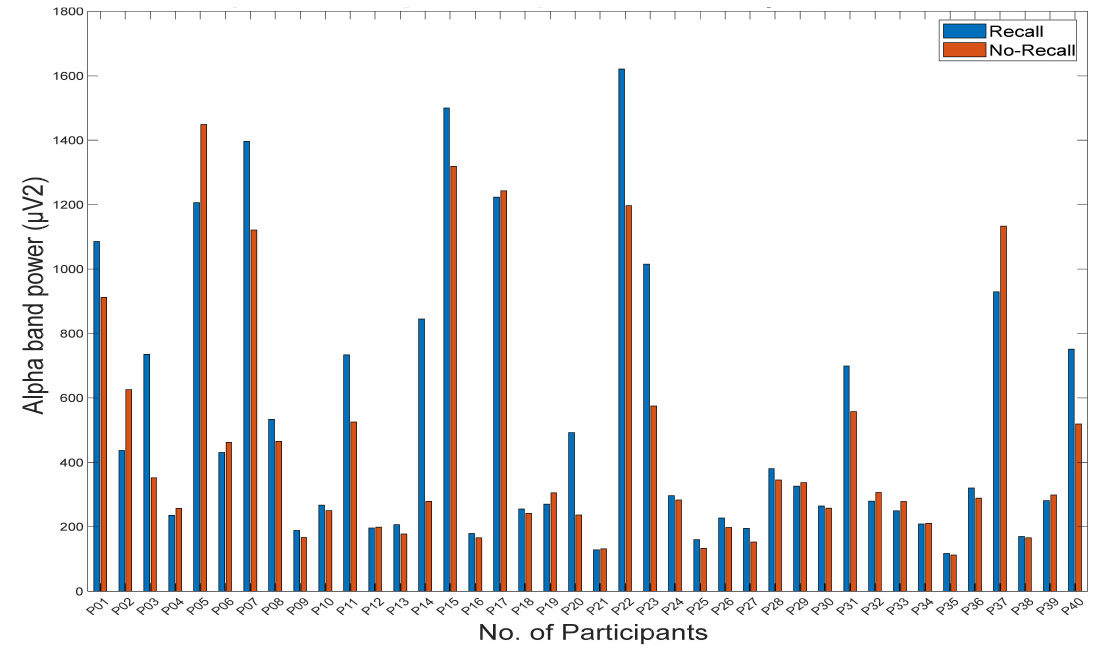
Figure 9. Comparison of alpha power for memory recall and no-recall.